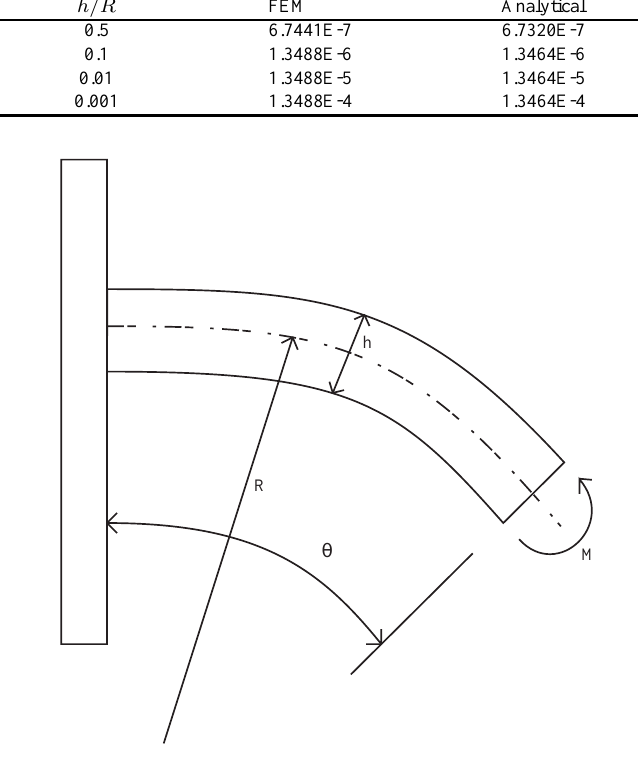
Fig. 4. Cantilevered curved